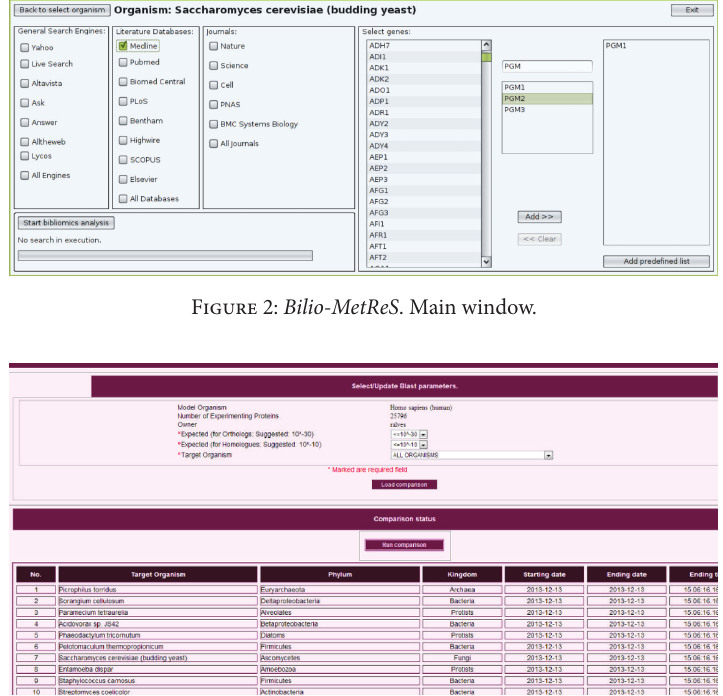
Figure 3: Homol-MetReS